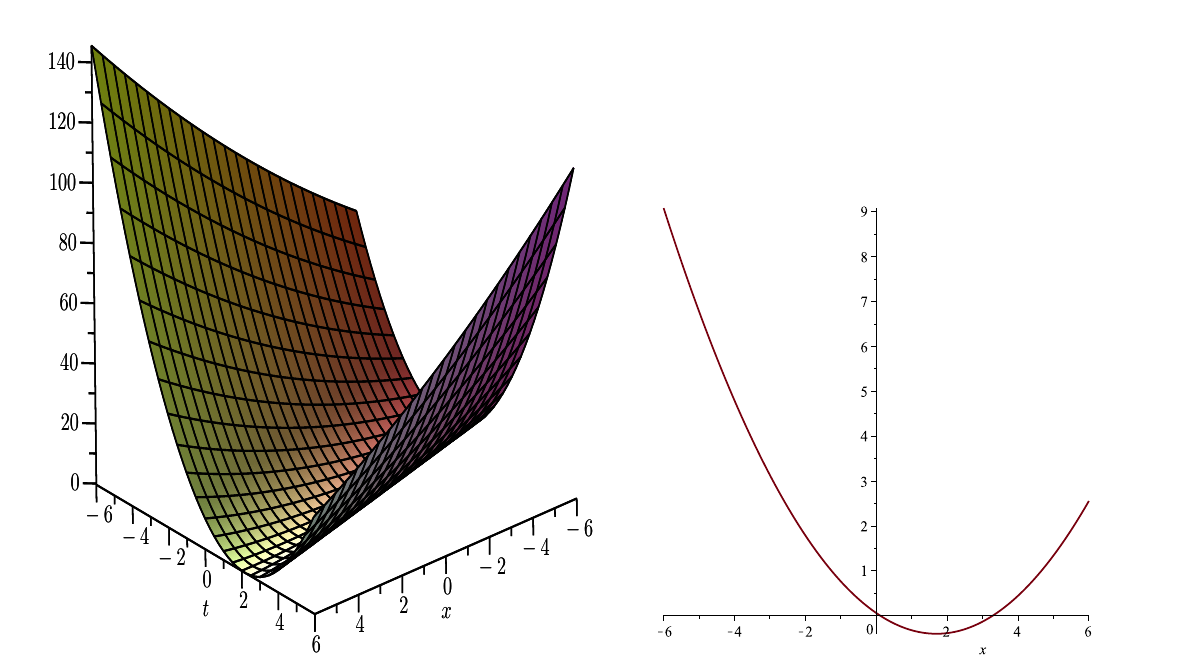
Figure 7. ( left ) 3D representation of solution (41) for ν = 0.5, κ = 0, ω = 1, ρ = 0, r = 1.5, p = 1, ξ = 3.7, ξ 0 = 2 and x , t 6 6. ( right ) 2D representation of solution (41) for t = 1 and − ≤ ≤